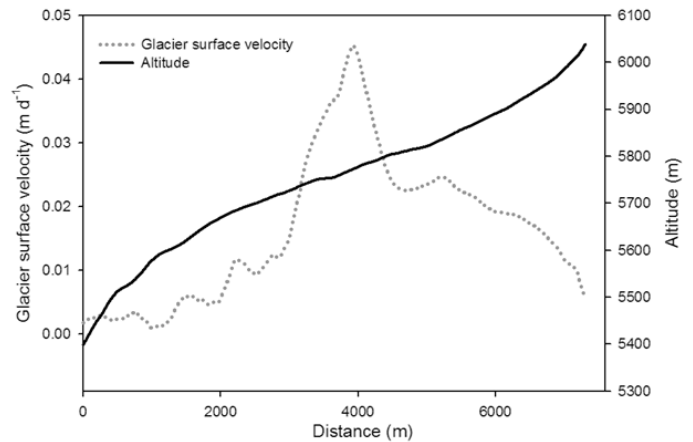
Figure 12. Ice flow velocities (in 2009) vs. altitude along the central flow line of glacier 5Z213E0012. The profile location is shown in Figure 6. In order to comparing with the results in 1996, the unit of glacier surface velocity was converted from m ∙ year − 1 to m ∙ day − 1 .